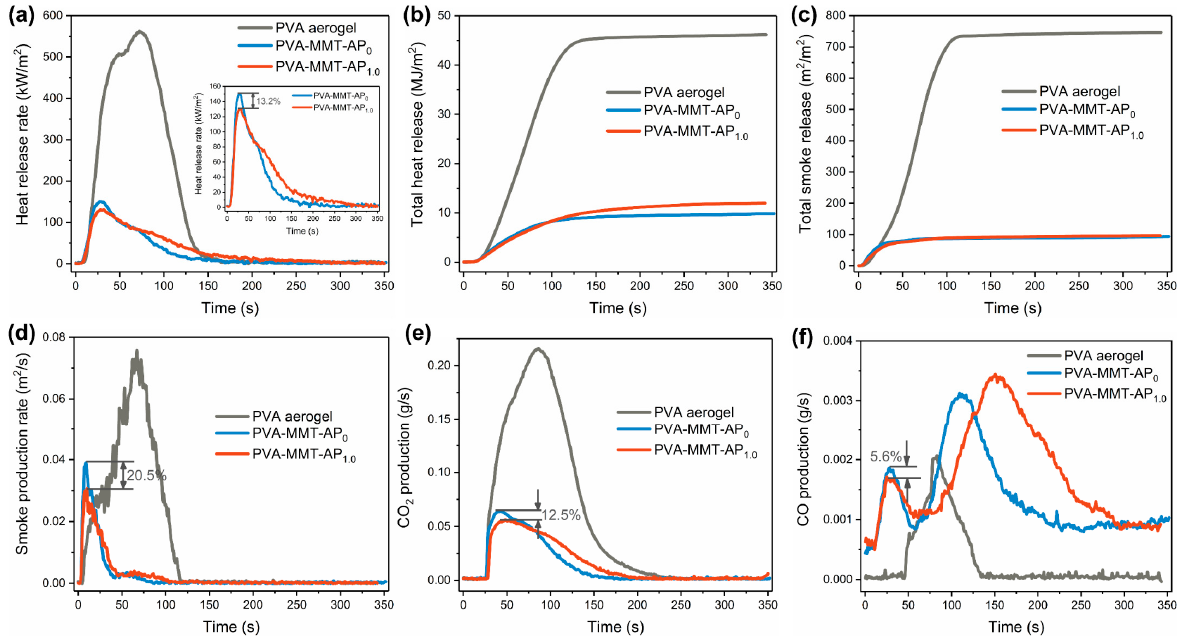
Figure 8. The ( a ) heat release rate (HRR), ( b ) total heat release (THR), ( c ) total smoke release (TSR), ( d ) smoke production rate (SPR), ( e ) CO 2 production and ( f ) CO production of the PVA aerogel, Table 2. The combustion parameters of the PVA aerogel, PVA-MMT-AP 0 and PVA-MMT-AP 1.0 .